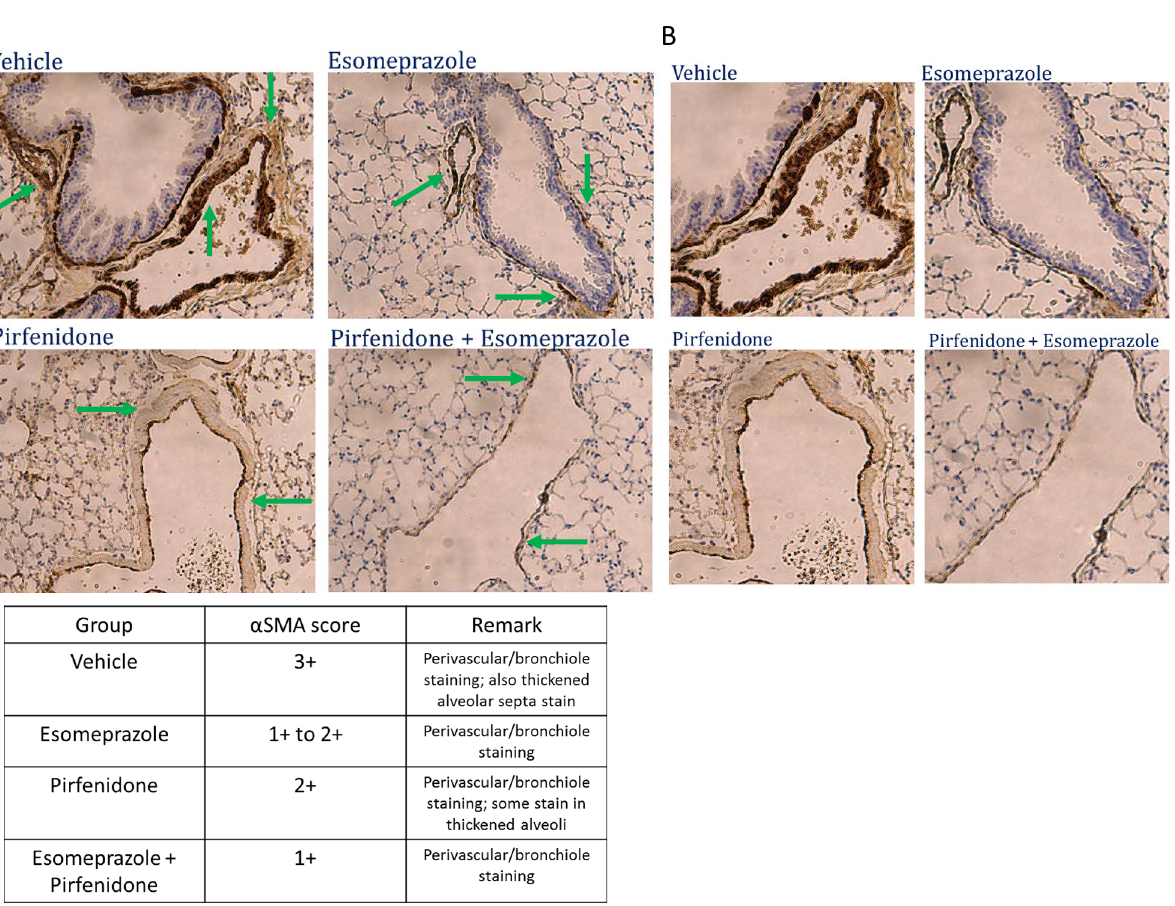
Figure 9. ( A ) Immunohistochemistry data showing alpha smooth muscle actin (αSMA) expression in a mouse model of TGFβ-induced lung fibrosis. The animals were challenged with adenoviral vector encoding TGFβ (6 × 10 6 pfu) and orally treated with vehicle (dH 2 O), esomeprazole (30 mg/kg), pirfenidone (100 mg/ kg) or esomeprazole (30 mg/kg) and pirfenidone (100 mg/kg) combination as described in the “Materials and methods” section. The data shows that the combination therapy inhibits lung tissue muscularization, as shown by reduced αSMA expression (brown stain), more effectively that the monotherapy (arrows). In panel ( B ), zoomed out images of the tissue included in the analysis are shown. The semi-quantitative scores are shown in the table and the data is representative of 5